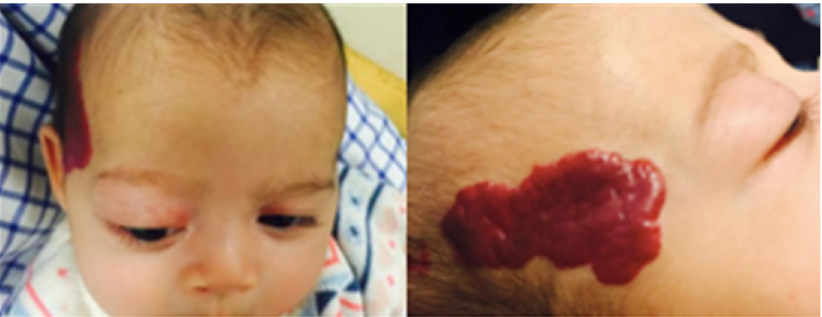
Figure 1. Infant on presentation. Large segmental plaque capillary hemangioma overlying the right temporal area. Marked proptosis with mild lagophthalmos.